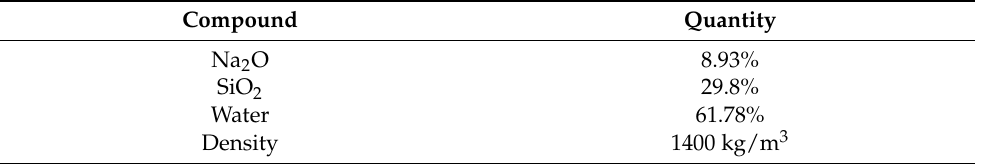
Table 4. The chemical properties of Sodium Silicate (SS)